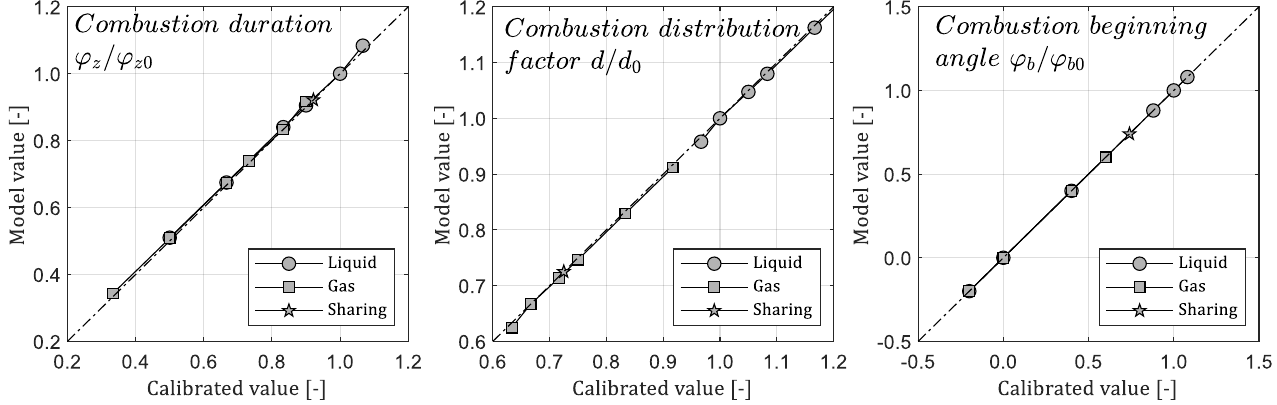
Figure 8. The calculated values from the SL model and the calibrated Wiebe parameters.